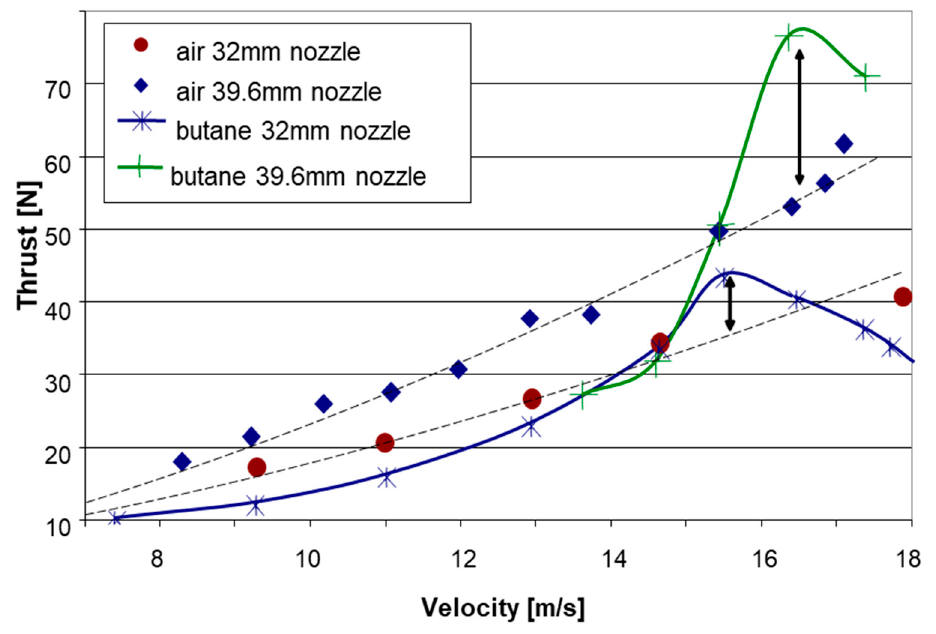
Figure 14. Test results of the thrust vs. velocity for LG butane and air at a constant air-equivalent flow rate of 17 g/s for nozzle exit diameters of 32 mm and 39.6 mm.